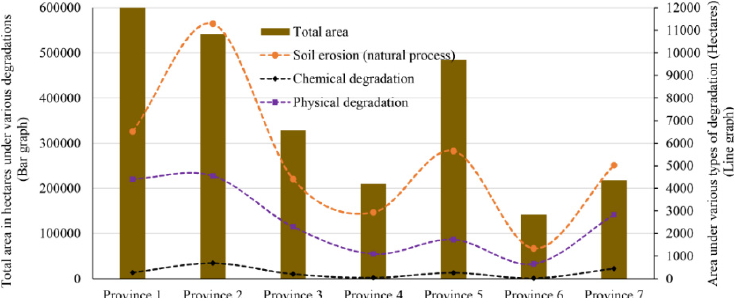
Figure 9. Land degradation due to natural process, physical and chemical degradation (Source: [43,57,58]).